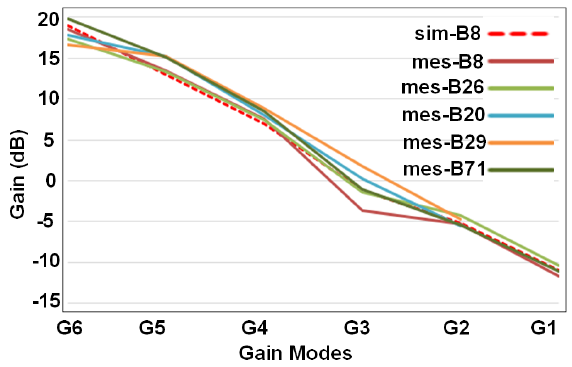
Figure 6. Simulated and measured gain modes for different